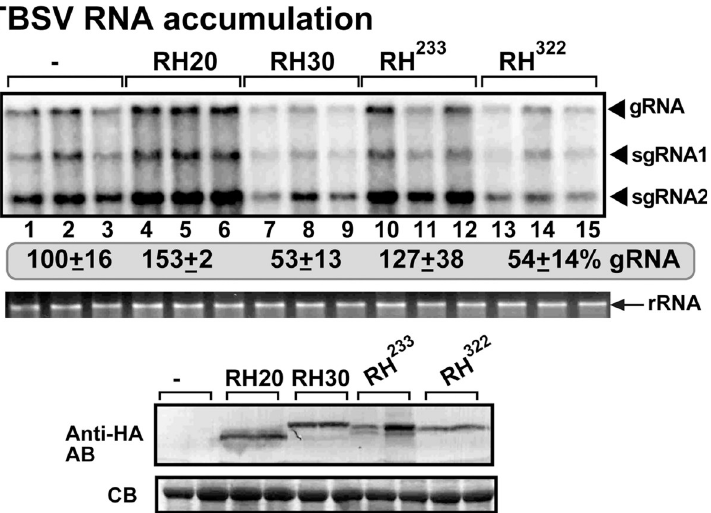
Fig 9. Effects of expression of chimeric DEAD-box helicases on TBSV replication in N . benthamiana plants. Top panel: Schematic representation of the chimeric helicases constructed based on RH20 and RH30 helicases. The chimeric helicases either contained the N-terminal domain of RH20 combined with the core helicase domain and C- terminal domain of RH30 (namely RH 233 ) or the N-terminal domain of RH30 combined with the core helicase domain and C-terminal domain of RH20 (namely RH 322 ). The plant leaves transiently expressing the chimeric derivatives of RH20 and RH30 helicases were inoculated with TBSV. Top panel: Northern blot analysis of tombusvirus gRNA using a 3’ end specific probe shows the accumulation level of gRNA and subgenomic RNAs at 1.5 days post- inoculation. Bottom panels: Western blot analysis of the level of HA-tagged chimeric derivatives of RH20 and RH30 helicases with anti-HA antibody. Each experiment was repeated at least three